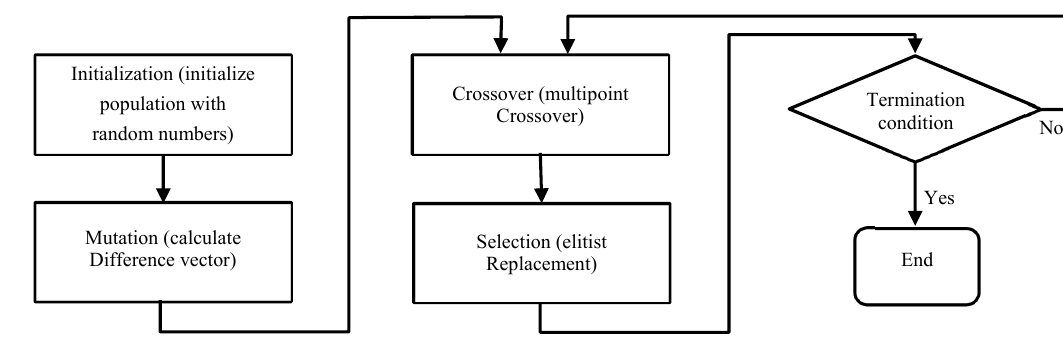
Figure 2. Main operations of DE algorithm.